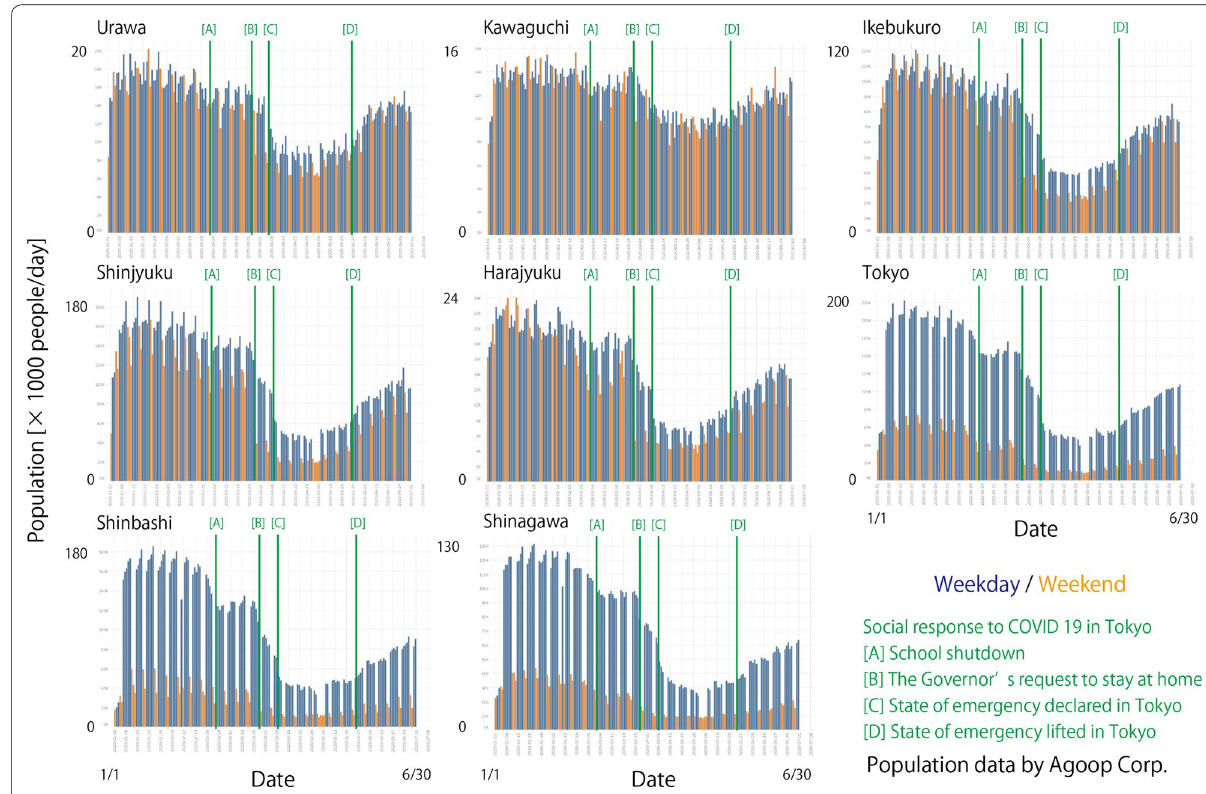
Fig. 3 Population at the train stations around MeSO-net stations. Population data were provided by Agoop Corp. This figure is modified from figures originally published by Agoop Corp. on their website (https ://corpo rate-web.agoop .net/pdf/covid -19/agoop _analy sis_coron aviru s.pdf; accessed on 1 July 2020) with their permission. Blue and orange bars represent daily population around stations for weekdays and weekends, respectively. Green lines represent the timing of government actions for